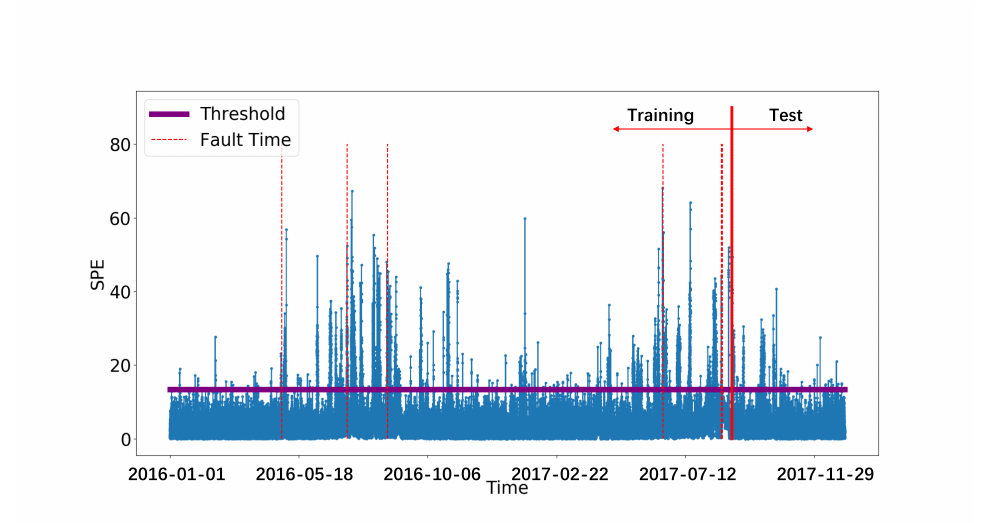
Figure 8. An example of the fault monitoring results of CCA, where the residual vector is represented by the SPE statistics and the threshold is computed by KDE.